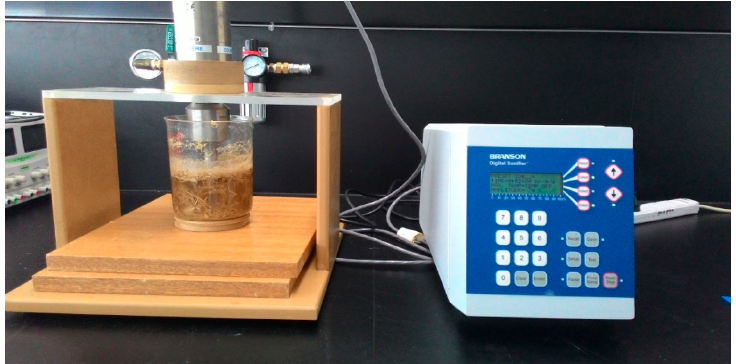
Figure 1. Branson digital sonifier.